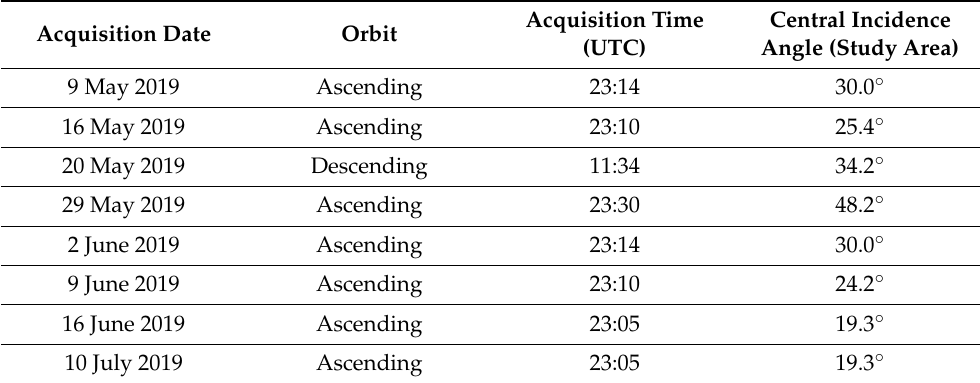
Table 2. Characteristics of collected RADARSAT-2